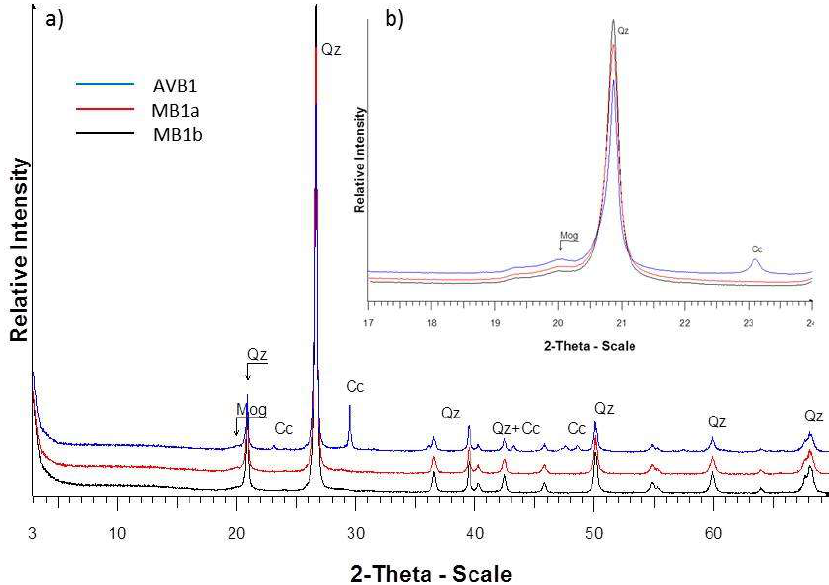
Figure 5. Representative diffractograms of the studied samples recorded in two different scanning areas: ( a ) Analysis of the bulk mineral compositions; and ( b ) Confirmation of the occurrence of moganite even in low amounts (Cc: Calcite; Mog: Moganite; Qz: Quartz).